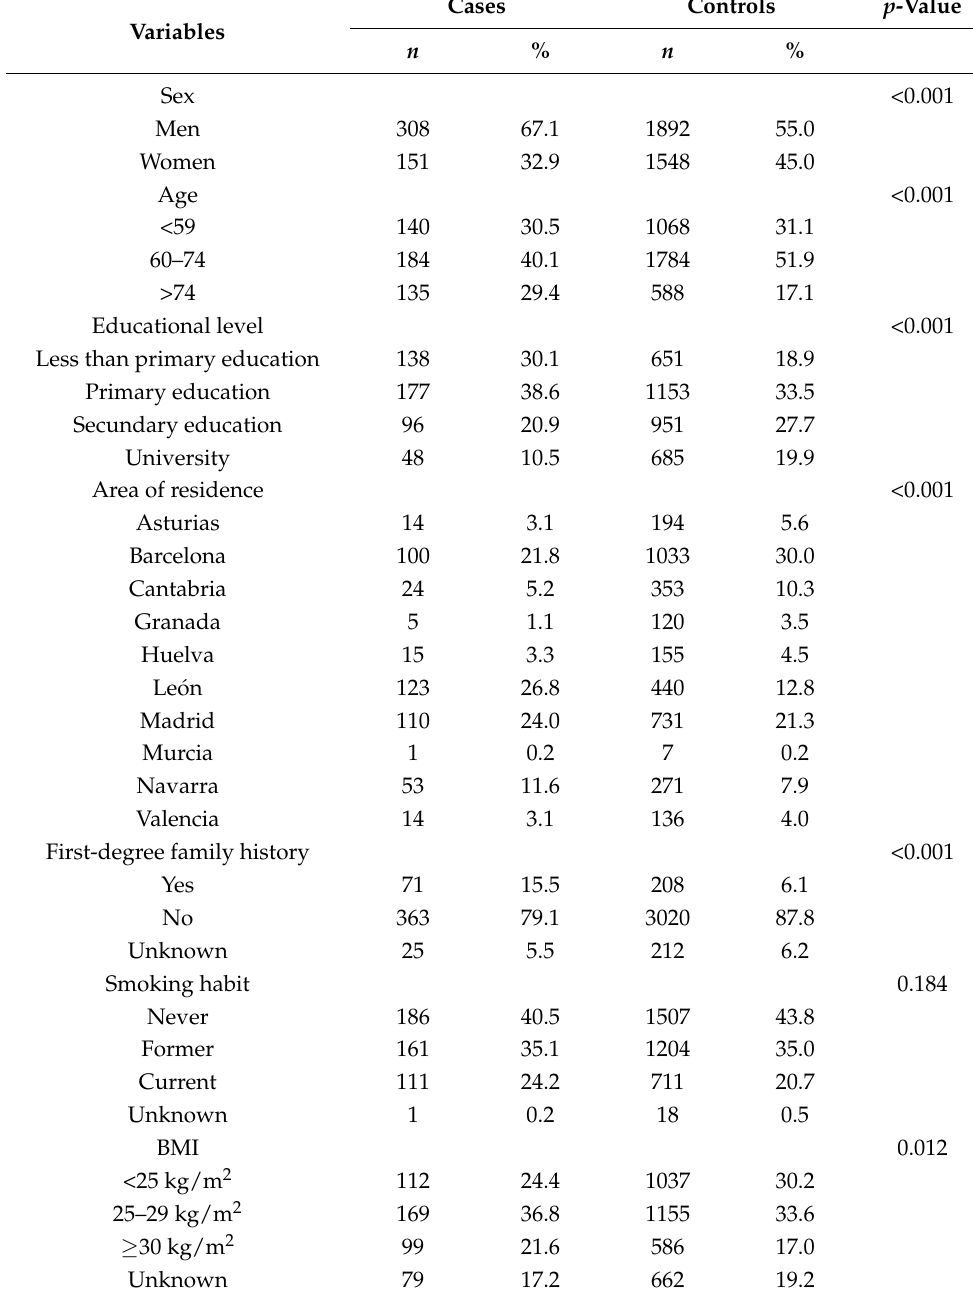
Table 1. General characteristics of cases and